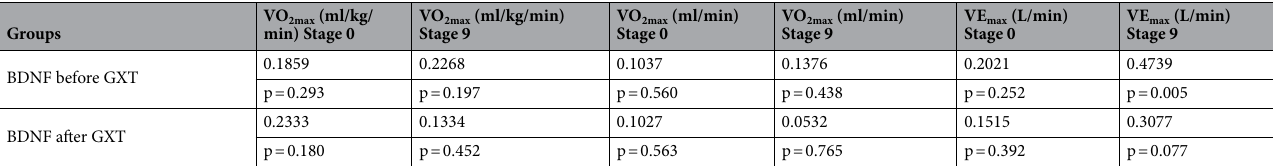
Table 5. BDNF correlation with LA and anthropological parameters at stage 9 (Person’s coefficient).